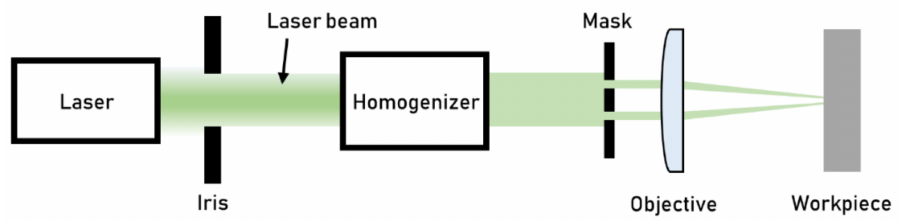
Figure 8. Working principle of through mask laser texturing.